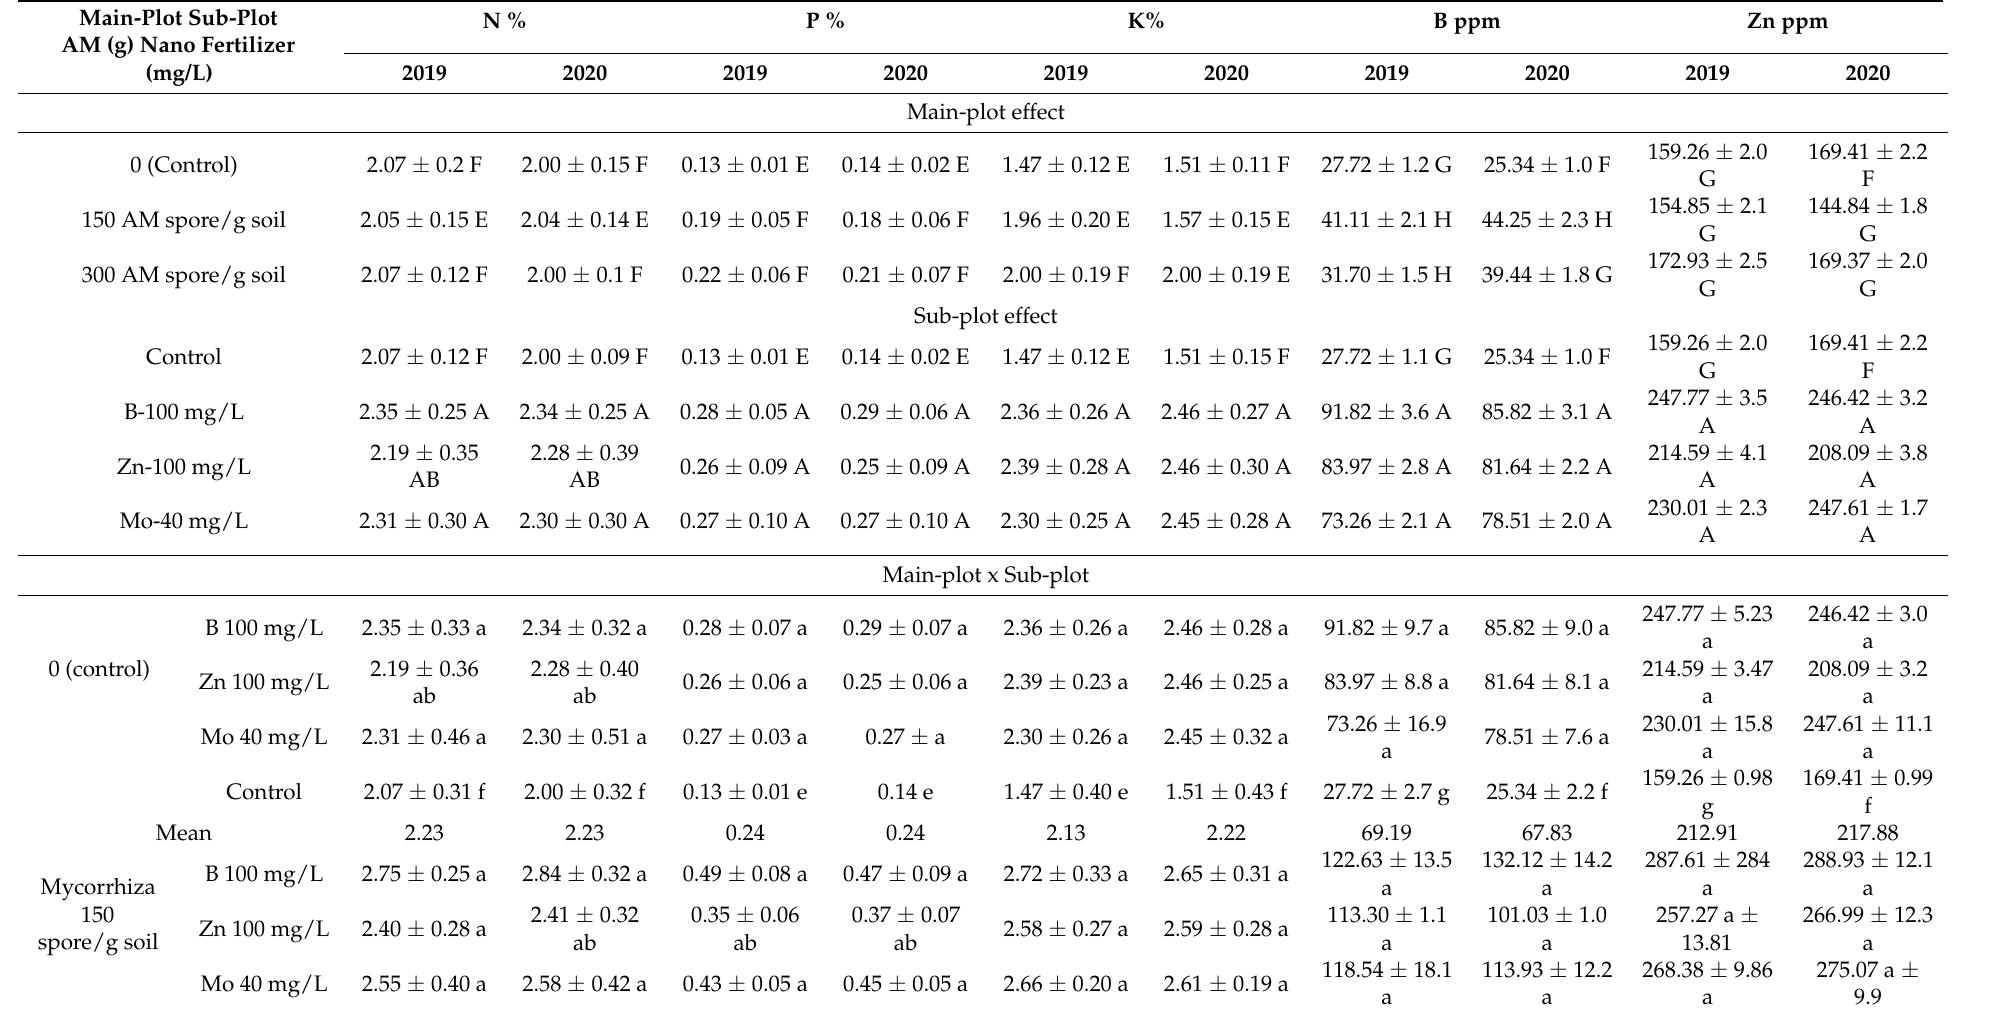
Table 4. Effect of arbuscular mycorrhiza (AM) and nano B, Zn, and Mo microelements on mineral contents of stevia plants during 2019 and 2020 seasons. Main-Plot